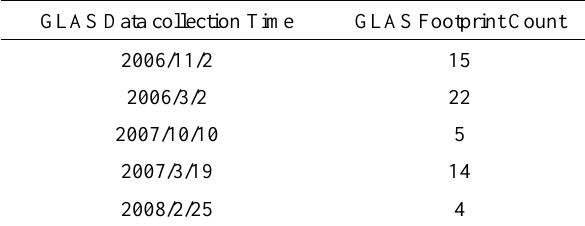
Table 3. GLAS data statistics after